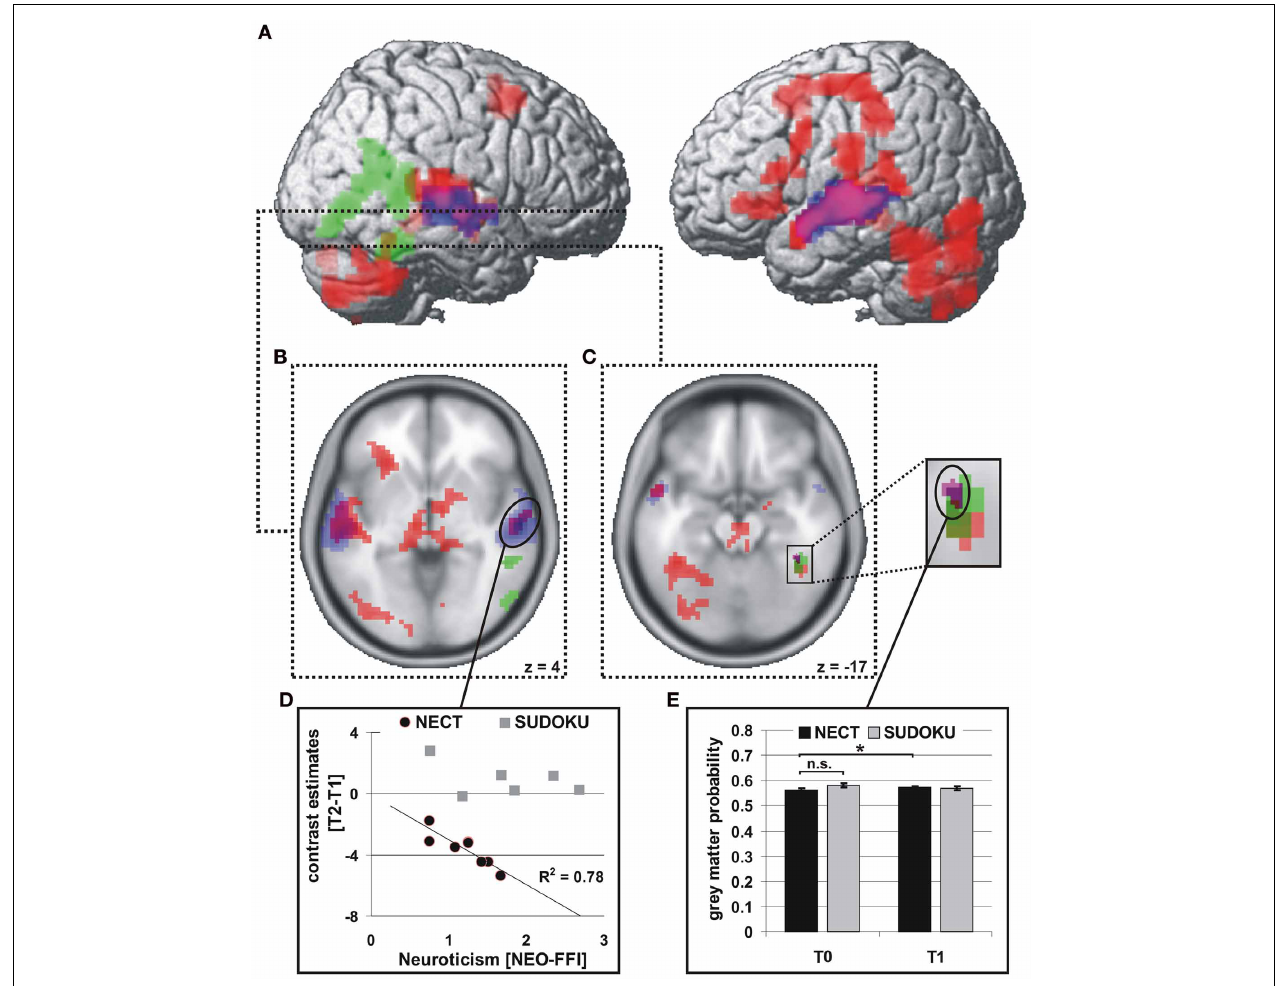
FIGURE 2 | Brain regions with significant functional and structural effects of NECT. fMRI: interaction of training type with time point of measurement (red; A–C ), p < 0 . 001, uncorrected, k > 47 voxels, corresponding to p < 0 . 05, FWE corrected at cluster level. Voice-selective areas (blue) and face-selective areas (green), p < 0 . 0001, uncorrected, p < 0 . 05 FWE whole-brain-corrected at